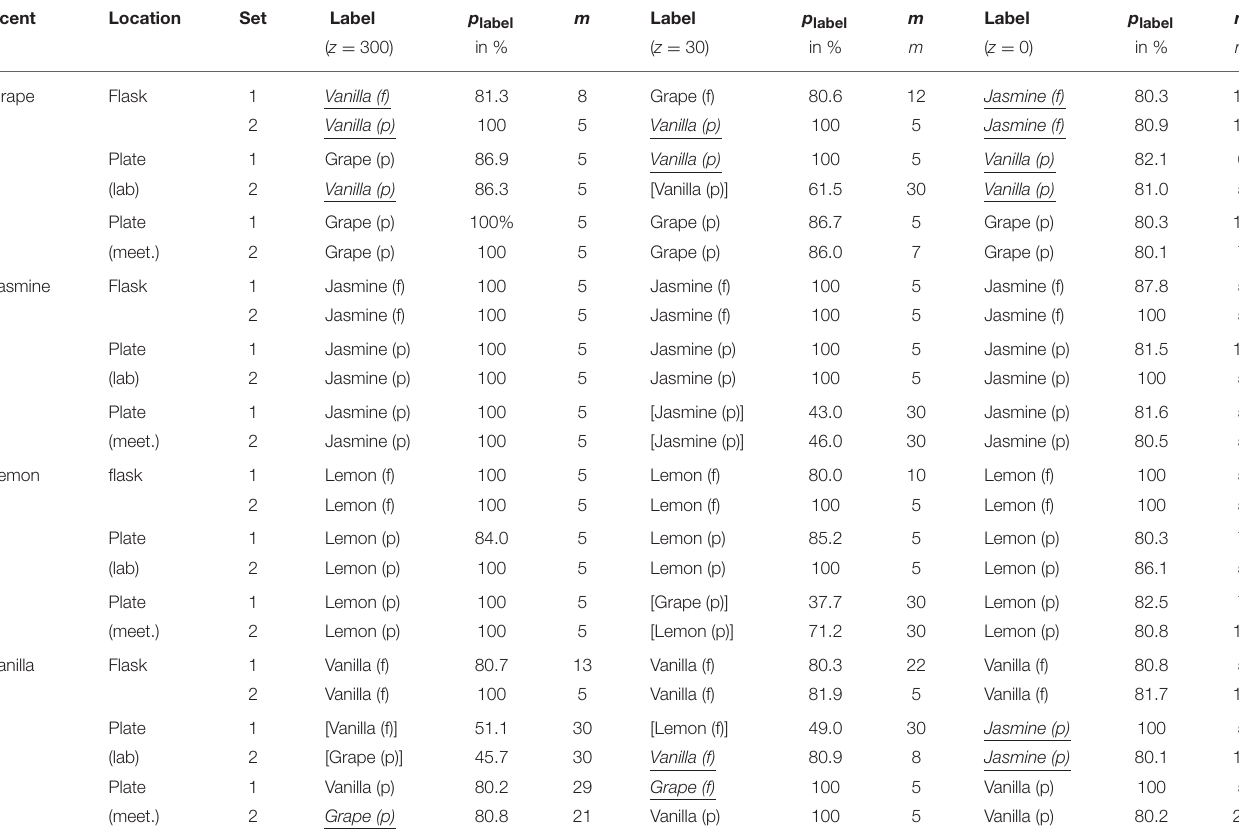
TABLE 1 | Classification results for tests in 3.1 with ( z = 300 and z = 30) and without ( z = 0) using baseline measurements. Scent